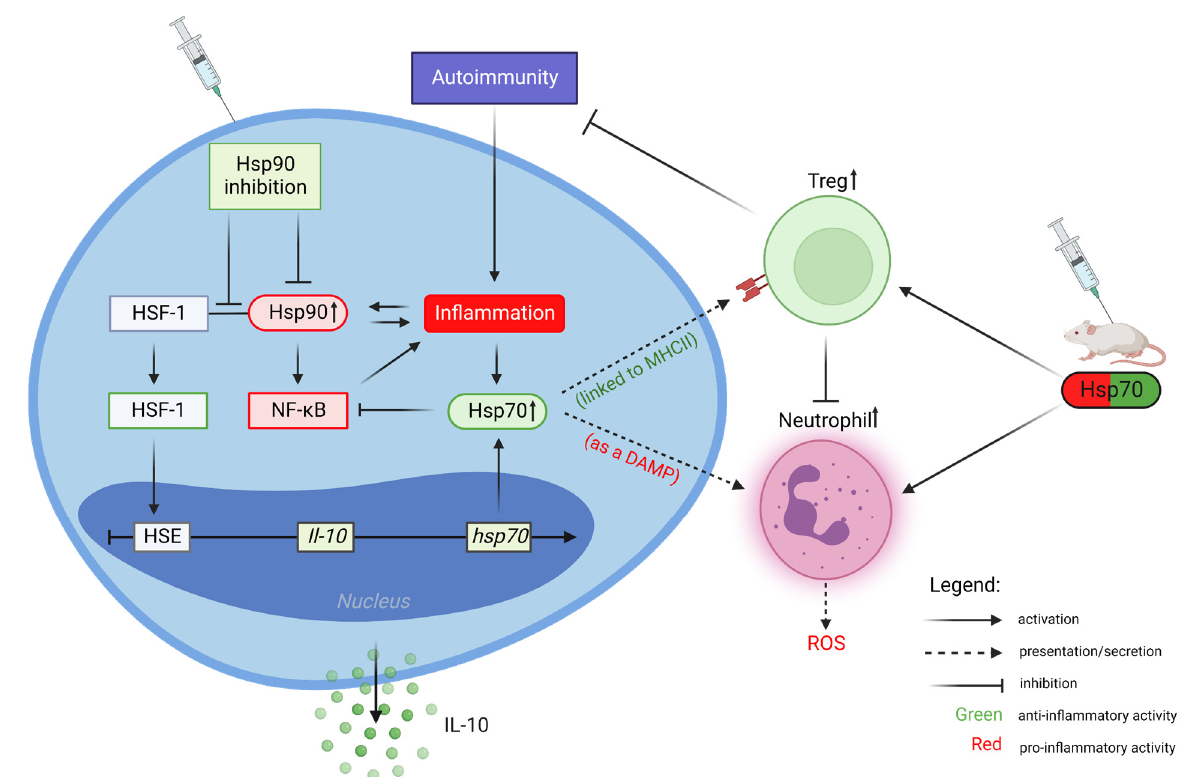
Figure 2. Contribution of Hsp90 and Hsp70 to the immune response and their significance in the therapy of autoimmune diseases. Inflammation leads to Hsp90 upregulation and, vice versa, Hsp90 promotes proinflammatory signaling. Blockade of Hsp90 activates heat shock factor 1 (HSF-1), which upregulates the expression of Hsp70 and IL-10. Stress stimuli or Hsp90 inhibition lead to the induction of Hsp70, which downregulates NF- κ B activation. In parallel, Hsp70 presented by major histocompatibility complex (MHC) class II molecules activates disease-modulating (immunosuppressive) T regulatory cells (Treg). On the other hand, acting as a damage-associated molecular pattern (DAMP), extracellular Hsp70 activates neutrophils and promotes the secretion of reactive oxygen species (ROS). Hsp70-based immunization stimulates either pro- or anti-inflammatory immune responses/cells. Created with BioRender.com (accessed on 11 August